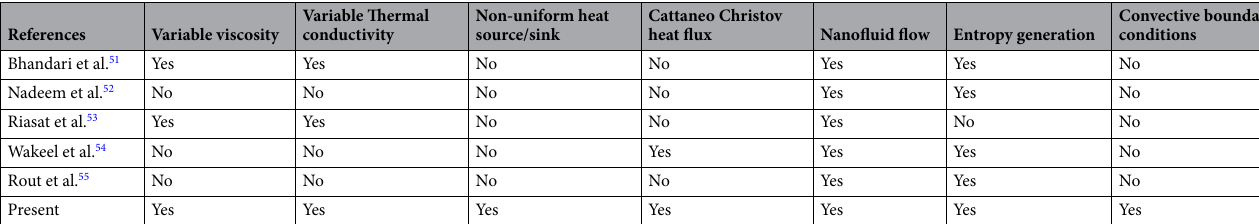
Table 1. A comparative analysis of the presented model with the published